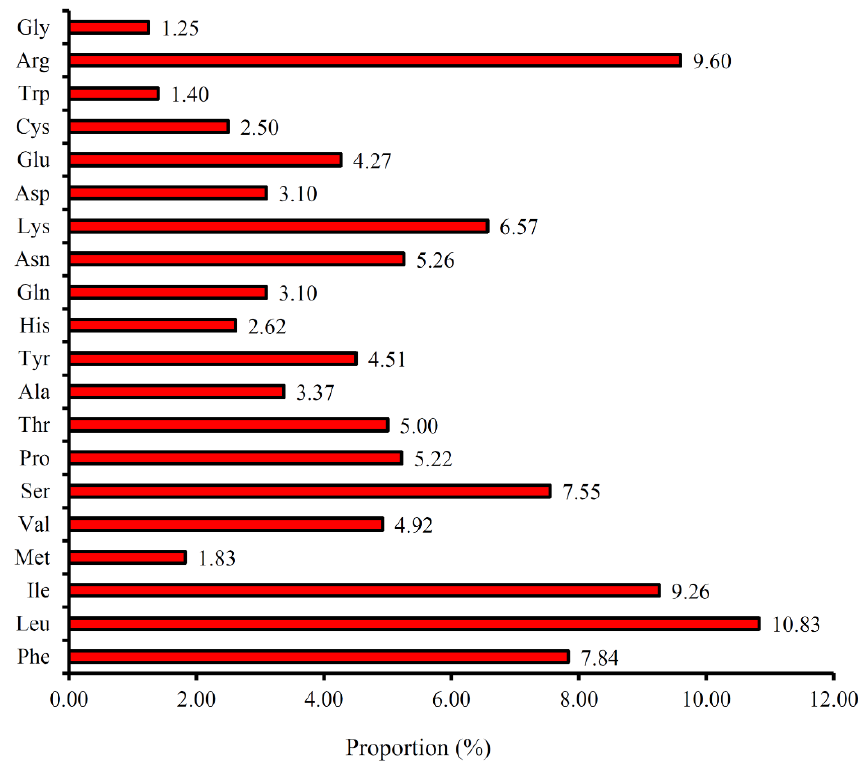
Figure 3. Amino acid frequencies in the P. angulata var. villosa plastome protein-coding sequences.